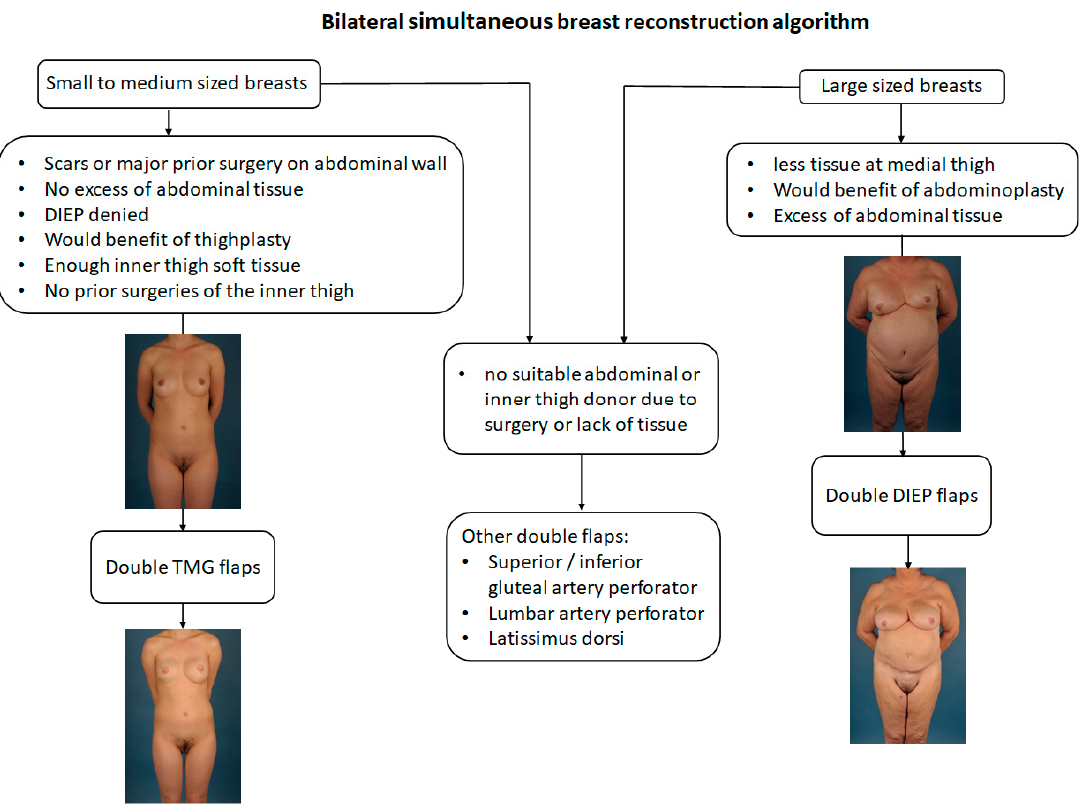
Figure 1. Algorithm for bilateral breast reconstruction with autologous tissue.